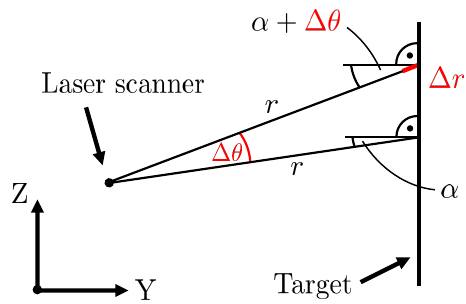
Figure 6. Estimation of the impact ∆ r on the measured distance r caused by an angular error ∆ θ as a function of the incidence angle α and the distance r between target and laser